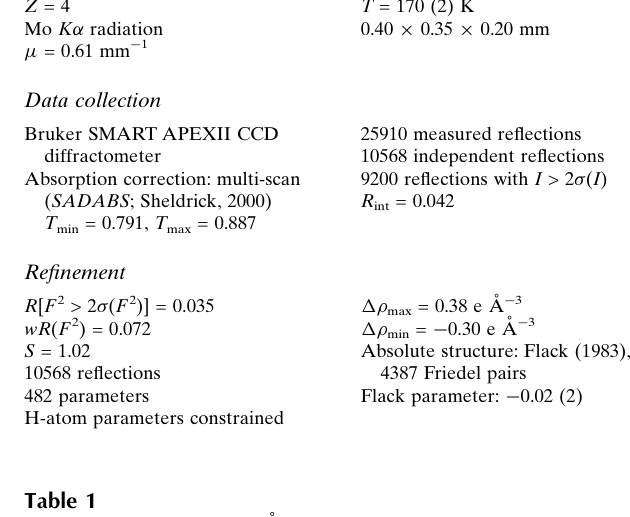
Hydrogen-bond geometry (A˚ , (cid:4) ). Cg 1 is the centroid of the C51–C56 phenyl